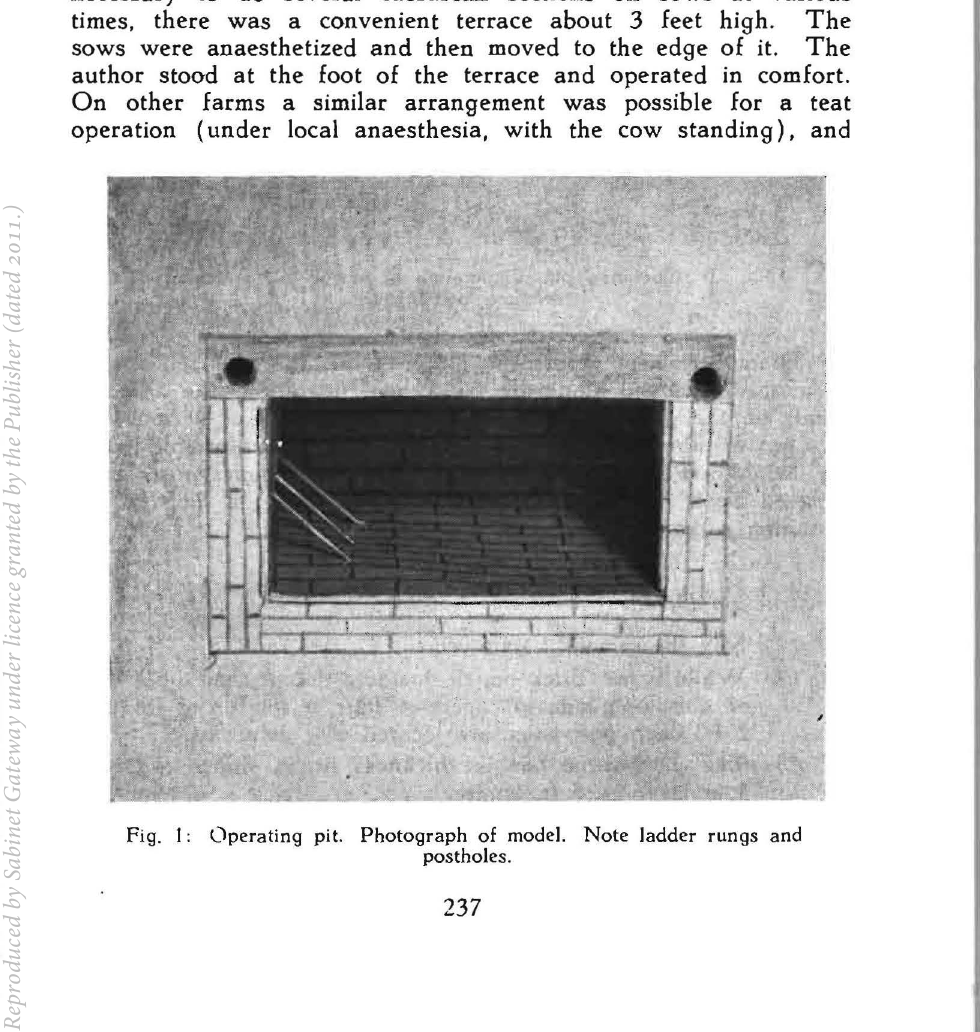
Fig. I: Operating pit. Photograph of model. Note ladder rungs and postholes.